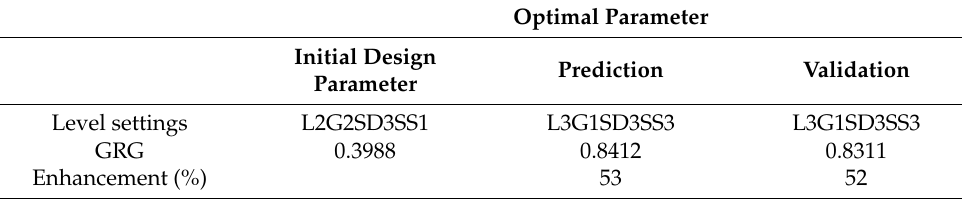
Table 9. Results of the validation